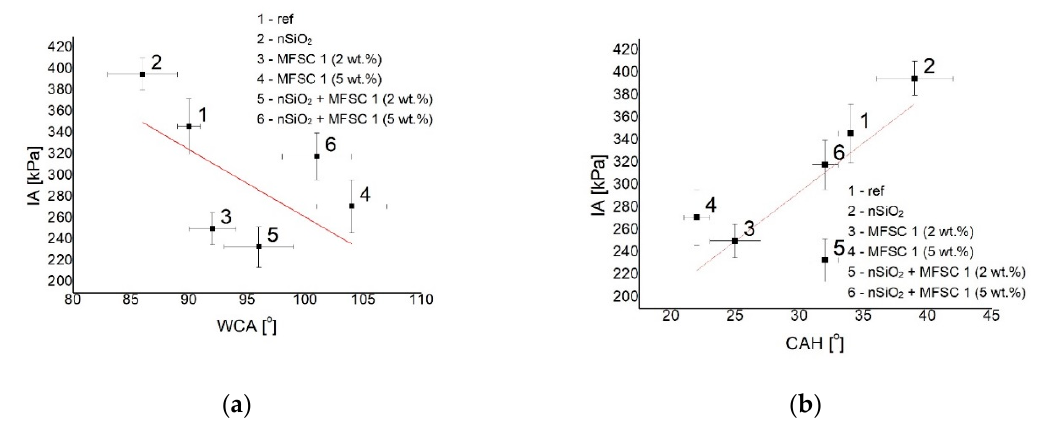
Figure 7. Relationship of IA as a function of ( a ) WCA and ( b ) CAH for samples modified with MFSC 1.